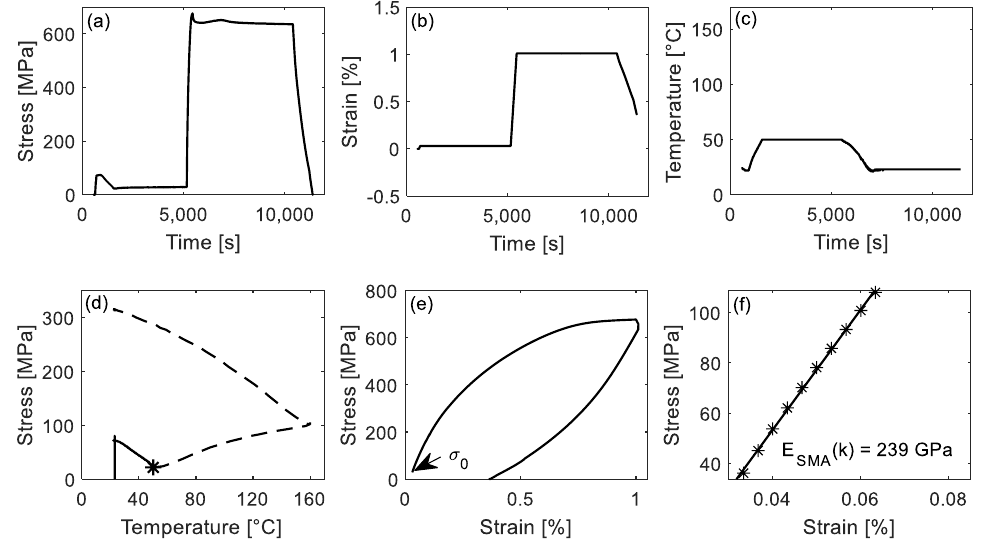
Figure 8. ( a – c ) Stress, strain and temperature versus time curves of the interrupted experiments to determine E SMA (50 ◦ C ↑ ). ( d ) Stress as a function of temperature during activation. The black star (50 ◦ C ↑ ) marks the point, at which E SMA was evaluated. ( e ) Stress-strain curve during loading to 1% strain and unloading. ( f ) The linear fitting (regression line) in the stress range from σ 0 + 5 to σ 0 + 80 MPa.